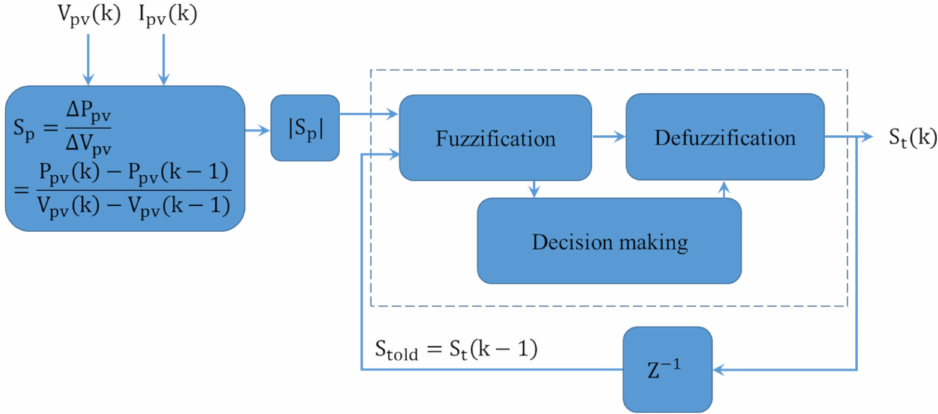
Figure 11. Variable step using Fuzzy control I.